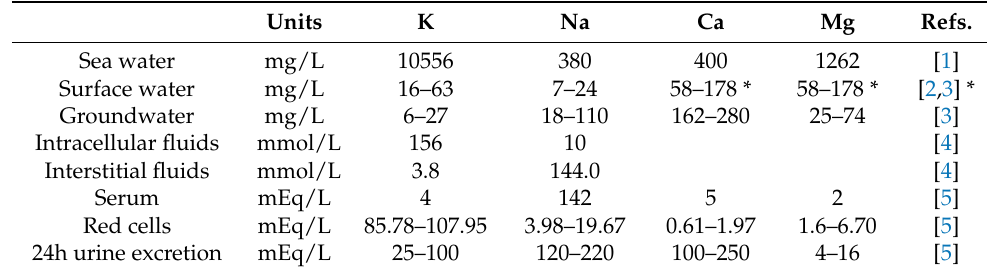
Table 1. Examples of the element